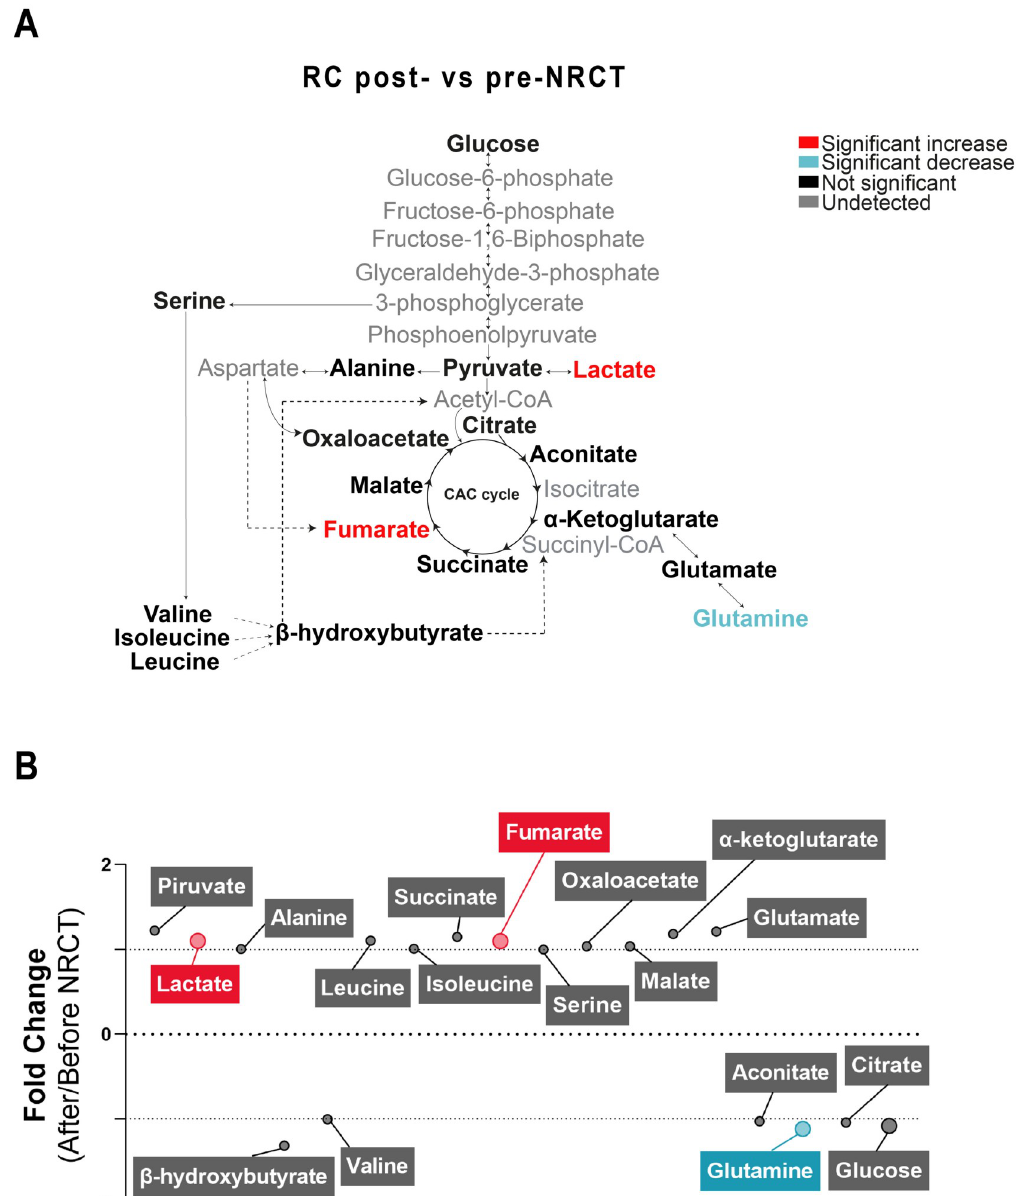
Fig 2. Plasma metabolic alterations in patients with Rectal Cancer (RC) after Neoadjuvant Radiochemotherapy (NRCT). (A) Schematised view of differences in metabolites related to the glycolytic pathway, citric acid cycle, and amino acid pathways between control and RC patients. Colours indicate statistical comparisons as shown in the legend. (B) Average fold changes of metabolite concentrations expressed as bubble plots. The bubble sizes estimate the magnitude of change. Colours represent a significant statistical increase (red), decrease (blue) or not significant